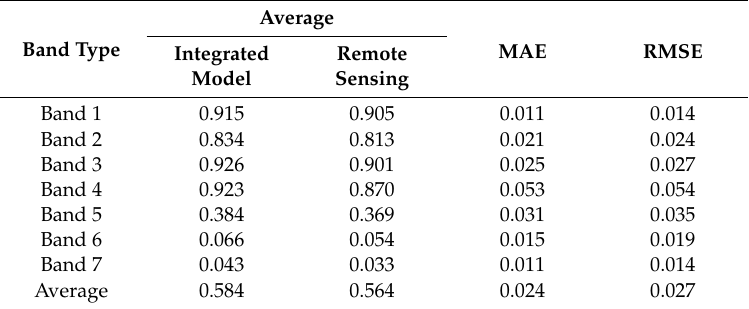
Figure 10. Comparison between the average narrowband snow albedo in 7 bands simulated by the integrated model and the average narrowband snow albedo in 7 bands retrieved by utilizing the MOD09GA reflectance data in the time series. The markers represent the daily average snow albedo of the whole study region. Table 3. Errors of the integrated model and remote sensing observations in different bands (including the average, MAE and RMSE).